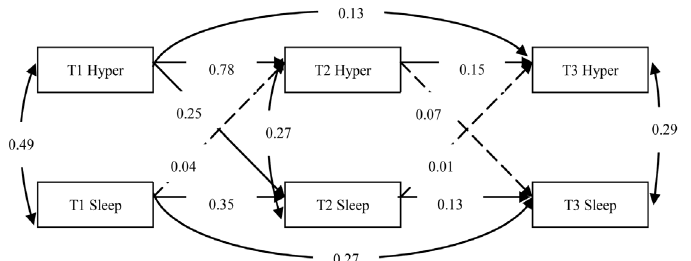
Figure 3. The model for the evaluation of the relationship between hyperarousal symptoms and sleep problems after controlling the other two symptom clusters of PTSD (Model 3). Dashed lines indicate insignificant paths. Hyperarousal symptoms=Hyper, Sleep problems=Sleep.